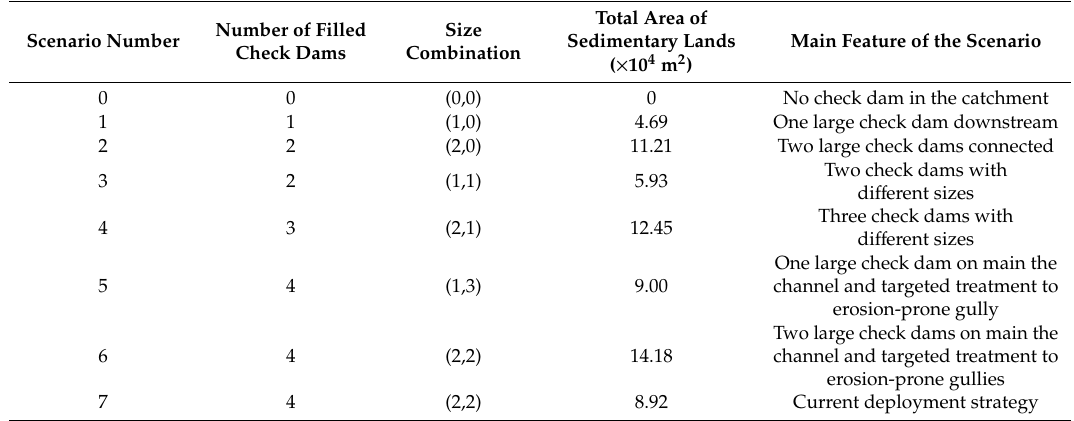
Table 2. Description of the eight scenarios in the